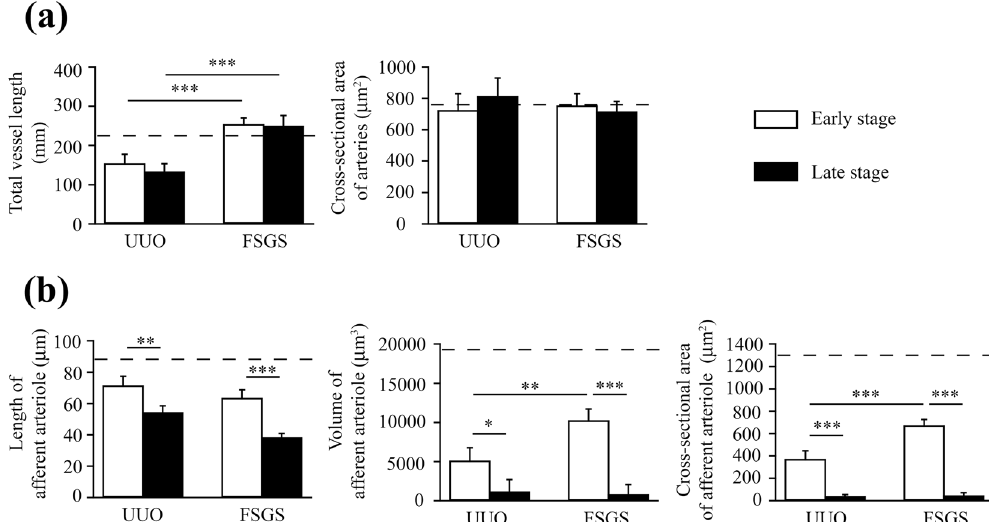
Figure 4. Distinguishing of the stages of renal lesions using an automatic 3D renal vessel tracing algorithm. ( a ) Total vessel length and cross-sectional area of arteries. ( b ) Length of afferent arteriole, volume of afferent arteriole and cross-sectional area of afferent arteriole. The horizontal dashed line indicates the level of the normal control mice. UUO-unilateral ureteral obstruction; FSGS-focal segmental glomerulosclerosis; TI- tubulointerstitial. n = 7 mice per group. * p < 0.05, ** p < 0.01, *** p <